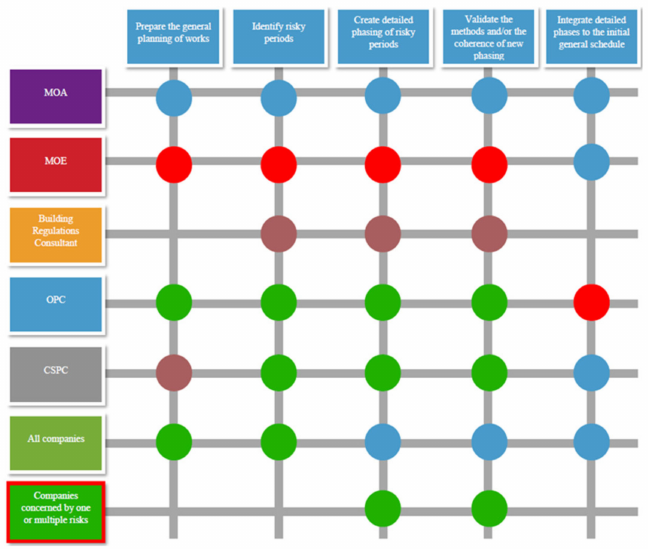
Figure 4. RACI matrix for implementing the scheduling process when using 4D